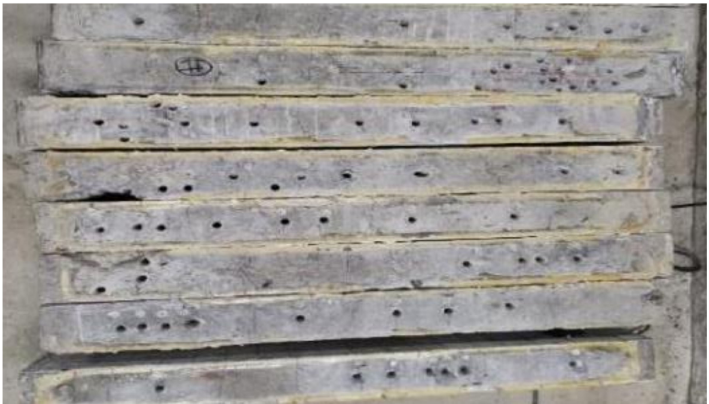
Figure 6. Distribution of detection points.